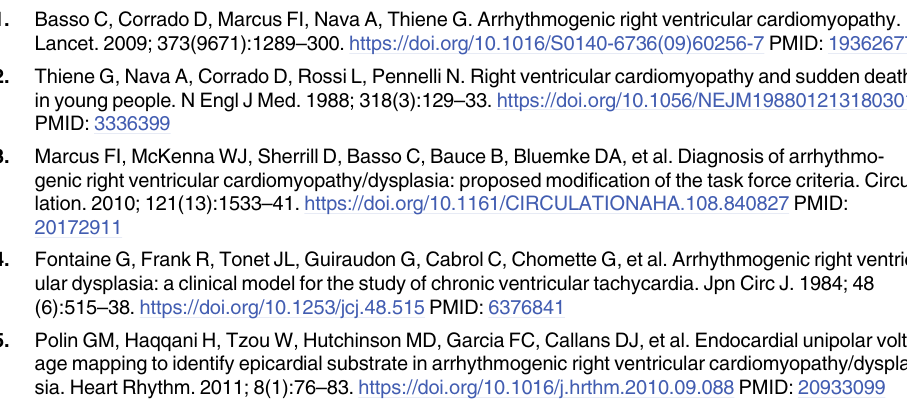
S1 Table. Summary of the repolarization and depolarization characteristics of the cohort. The table summarizes the main findings of the study regarding repolarization and depolariza- tion and compares them with the findings from a 12-lead ECG. (Tw: T-wave, TwI: